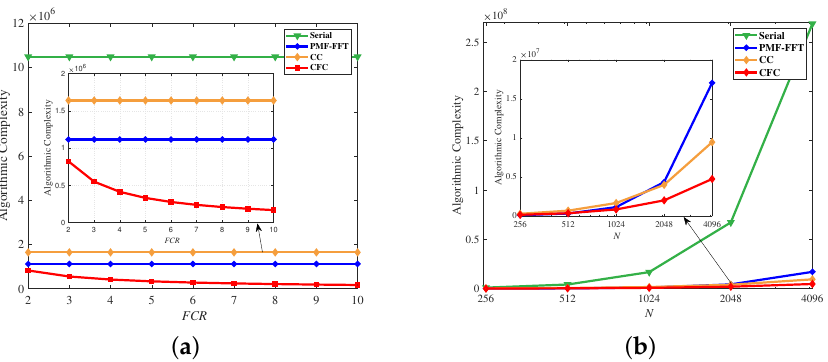
Figure 9. Algorithm complexities with different FCR and N : ( a ) FCR varies from 2 to 10; ( b ) N varies from 256 to